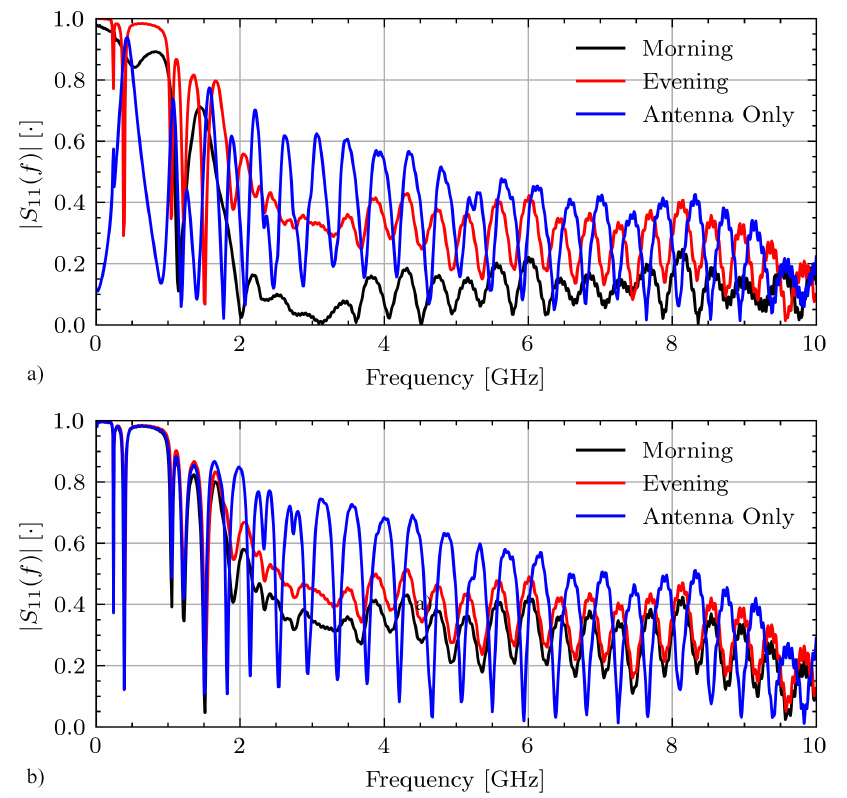
Figure 7. Measured | S 11 ( f ) | signals for Volunteer A while fasting on ( a ) day 1 and ( b ) day